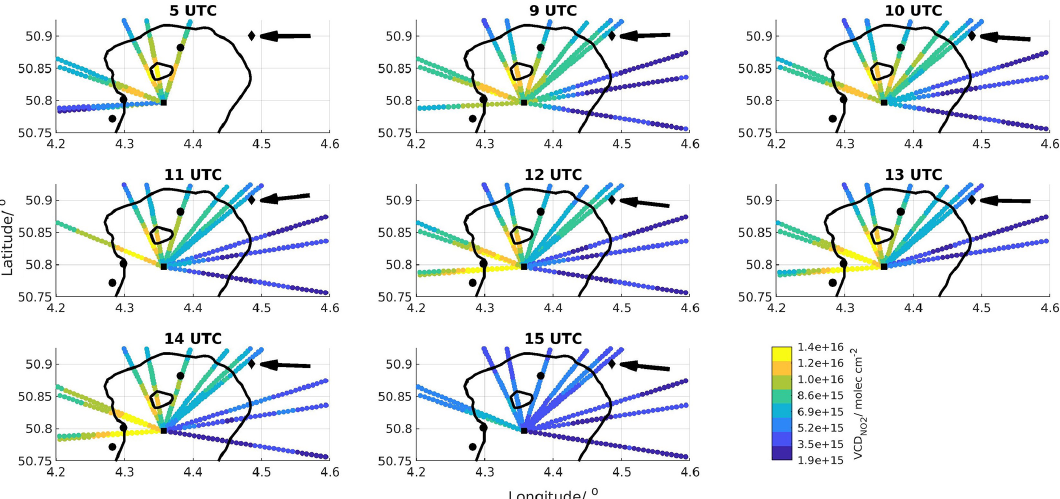
Figure 18. Maps of hourly averaged NO 2 horizontal profiles per azimuthal direction for 28 June 2019 corresponding to Fig. 17. The wind direction is shown with the black arrow. The black square shows the MAX-DOAS instrument location, the black polygon the national airport, the black dots the NO 2 hotspots emitting more than 10kgNO x h − 1 (Emission Inventory of the Belgian Interregional Environment Agency, 2017; Frederik Tack, personal communication, 2019), and the black line the Brussels Ring road.